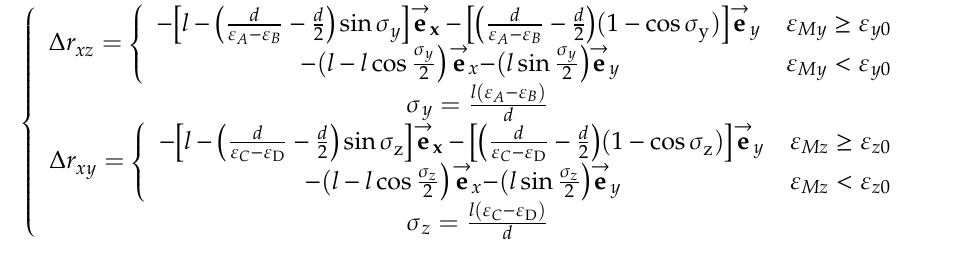
σ y along the direction of Y axis in the node coordinate